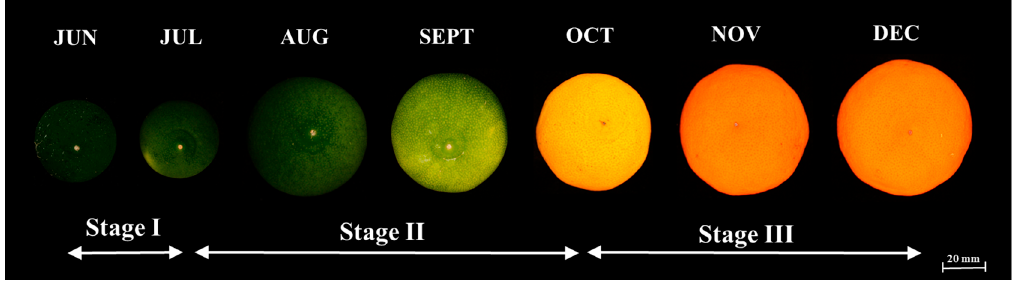
Figure 2. Growth and development stages of Satsuma mandarin in Japan.